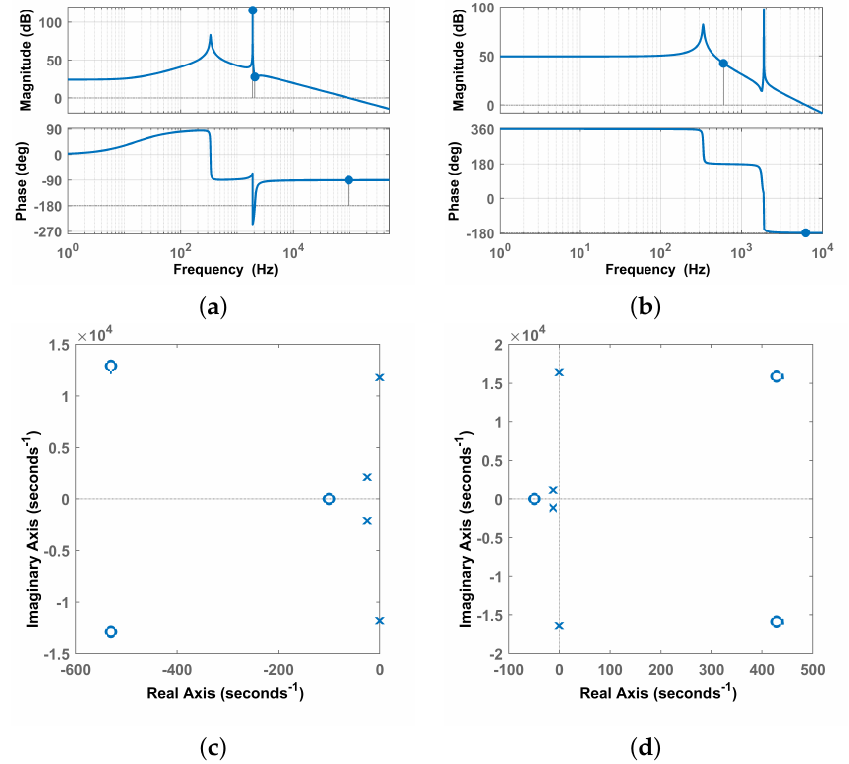
Figure 4. TF buck mode for ( a ) Bode plot Gi L 1 d _ d ( s ) . ( b ) Bode plot Gvd _ d ( s ) . ( c ) Pole and zero mab for Gi L 1 d _ d ( s ) , ( d ) Pole and zero map for Gvd _ d ( s )